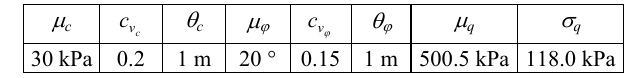
Table 4. Mean values and coefficients of variations assumed for soil strength parameters together with mean value and standard deviation of bearing capacity